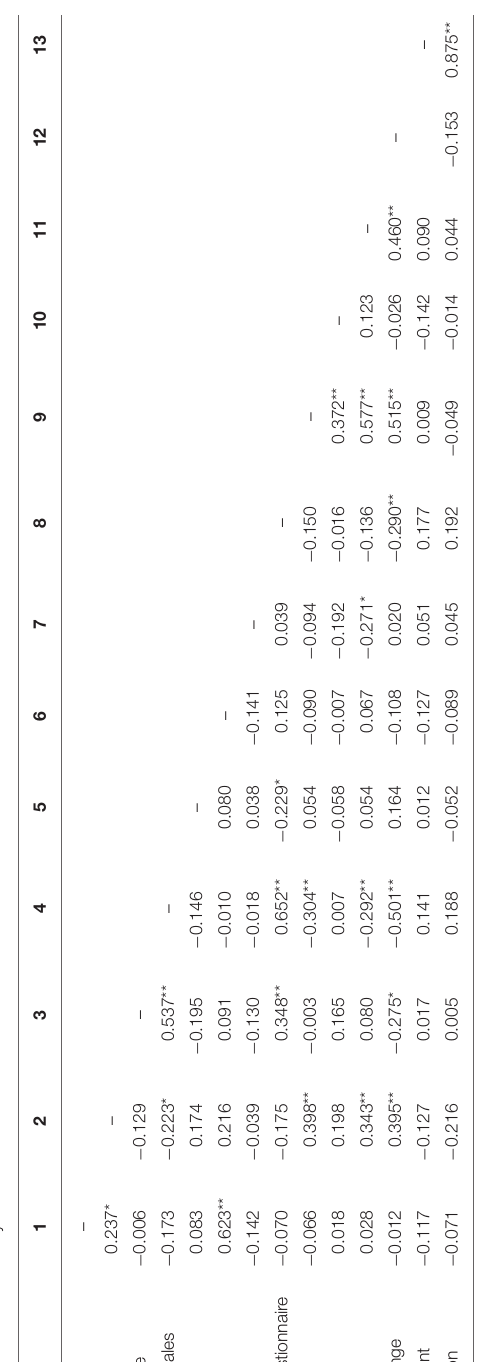
The standardized parameter estimates in Table 3